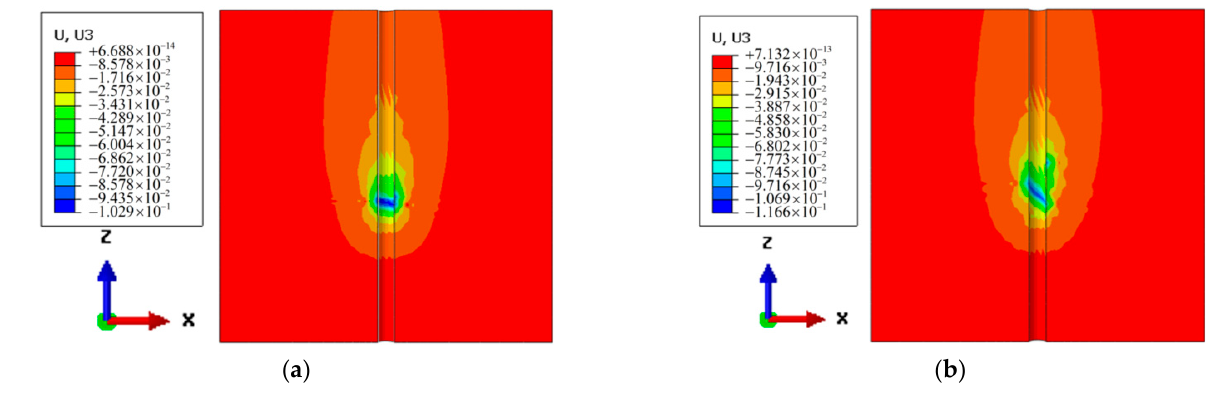
Figure 13. Displacement nephograms of soil around a pile with displacement of 0.1 m. ( a ) P1; ( b ) P5.